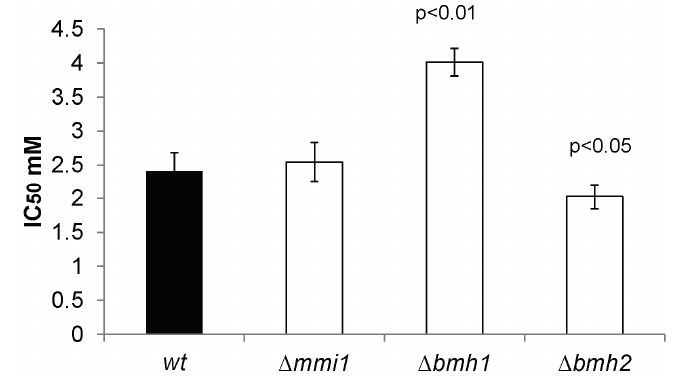
Figure 2. Resistance to cisplatin of Δ mmi1 , Δ bmh1 , Δ bmh2 and their parental wild-type strain